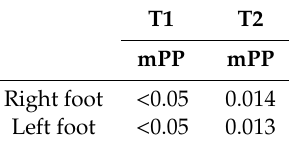
Table 4. Friedman test results for individual comparison of each foot and time in all movements.